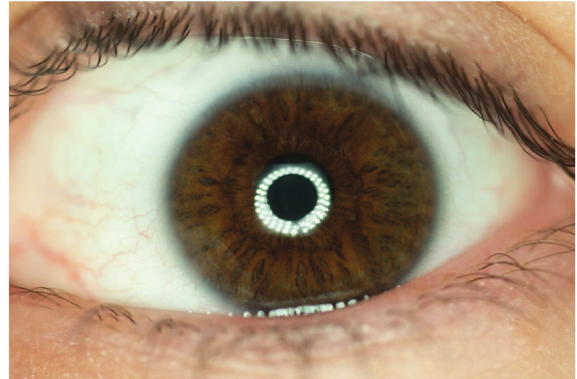
Figure 4 Detailed image of